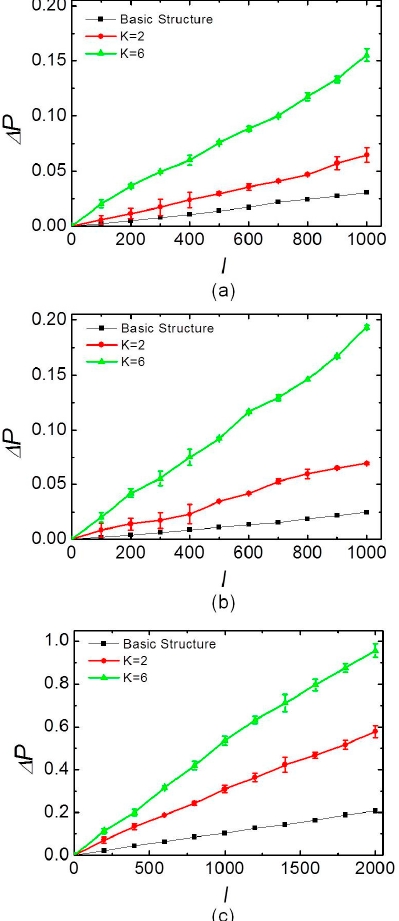
Figure 5. Relationship between the output signal ∆ P and the current I for ( a ) Channel 1; ( b ) Channel 2; and ( c ) Channel 3.